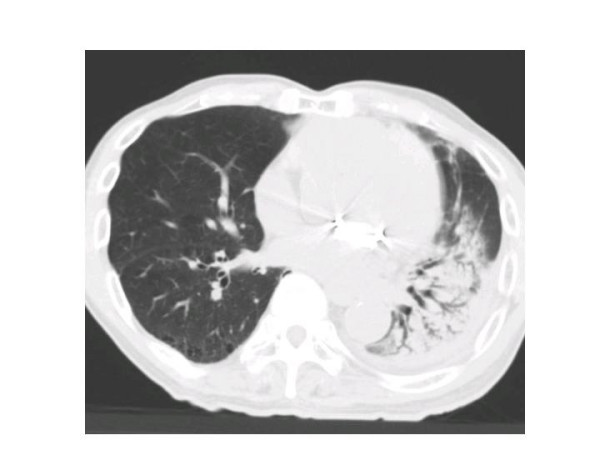
Computed tomography (CT) image of radiation pneumonitis (RP) (patient No. 11).